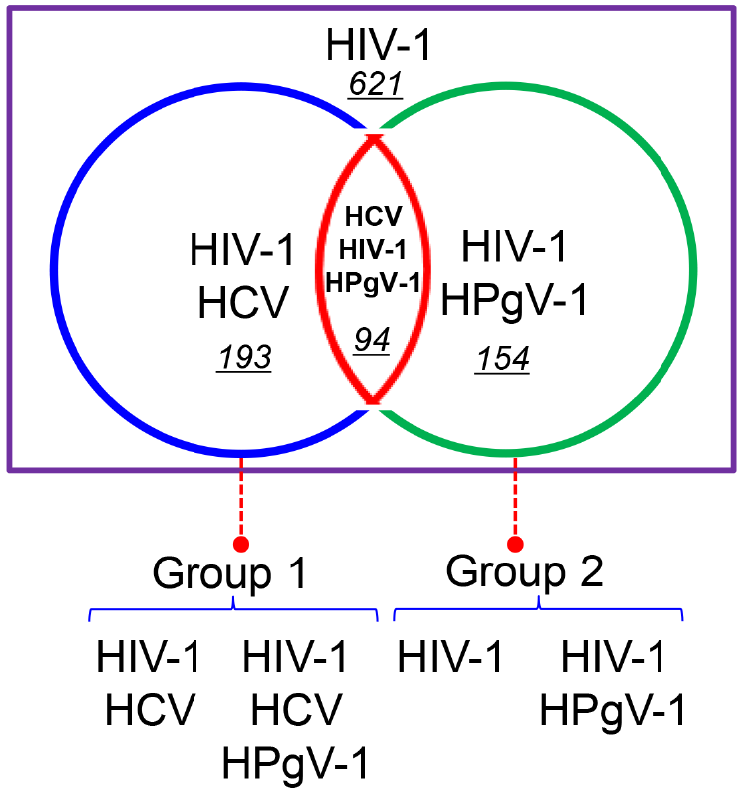
Figure 3. A graphical representation of HIV-1 mono-, HIV-1/Hepatitis C Virus (HCV) co-, and HIV-1/HCV/HPgV-1 triple-infection cases in our cohort in Yunnan, China. 621: the numbers of HIV-1 mono-infection, 193: HIV-1 and HCV co-infection, 154: HIV-1 and HPgv-1 co-infection, and 94: HIV-1, HCV and HPgv-1 triple-infection. Different groups are shown in different colors, as indicated at the bottom of the graphic.